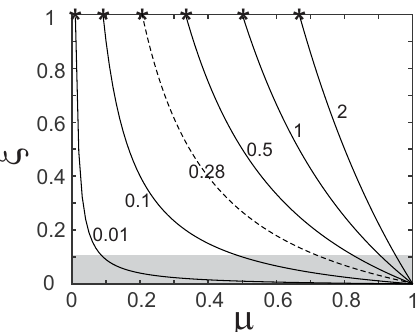
Figure 3. Dependence of ξ vs. µ . Numbers are the dimensionless ratios δq ∗ /q 1 . Critical mixing ratios µ cr are indicated by stars. Grey color indicates the area where the moments of homogeneous and extreme inhomogeneous mixing may not be segregated from in situ measurements. Dashed line was calculated for the cloud in Figs. 13–